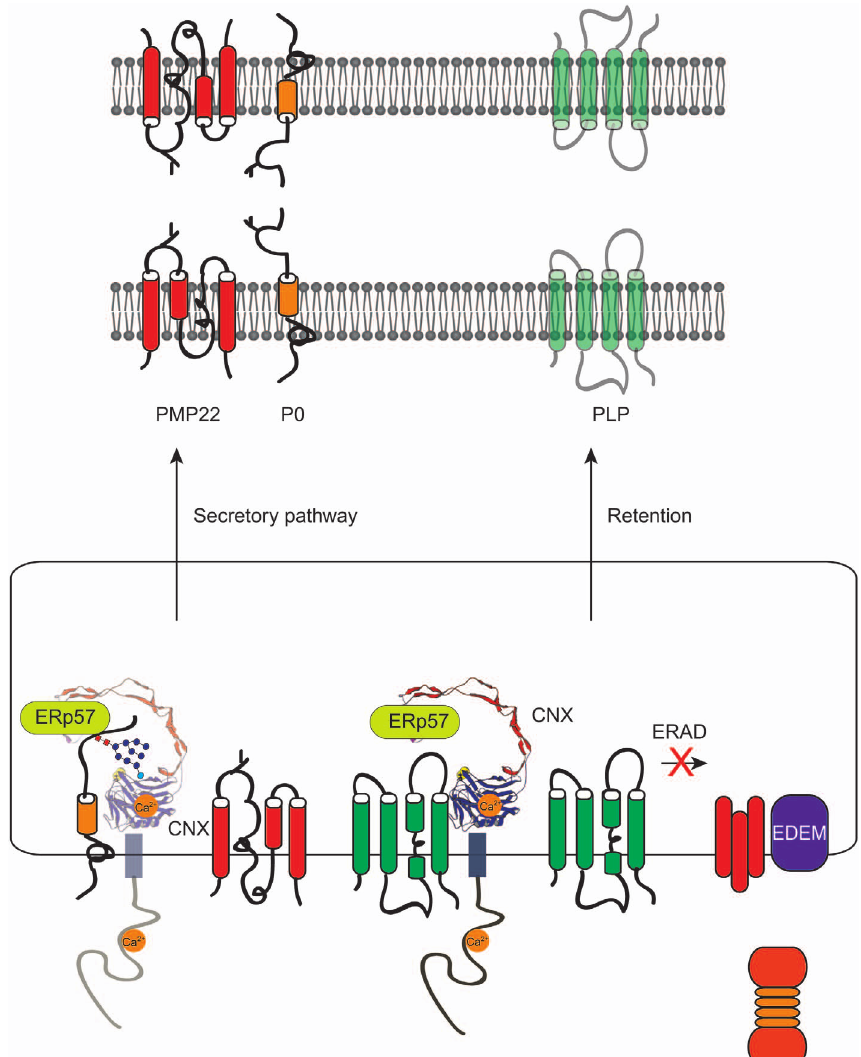
Figure 3 Quality control of myelin